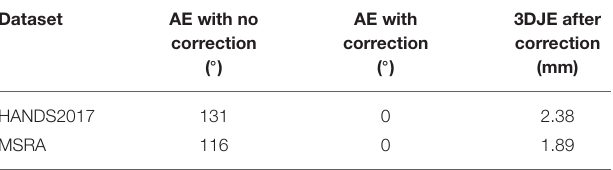
TABLE 1 | Anatomical Errors (AE) of the HANDS2017 dataset and MSRA dataset ground truth and the 3DJE of the corrected ground truth to the non-corrected version.